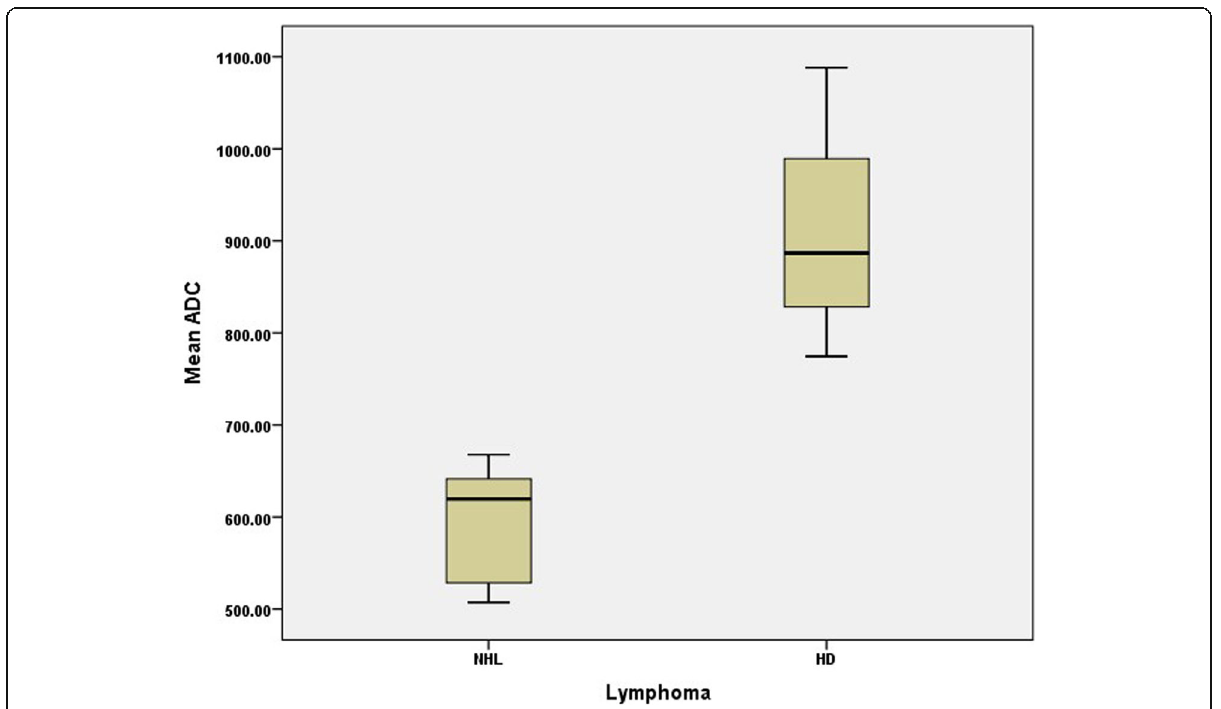
Fig. 7 Bar-and-Whisker plot: ADC mean values of NHL and